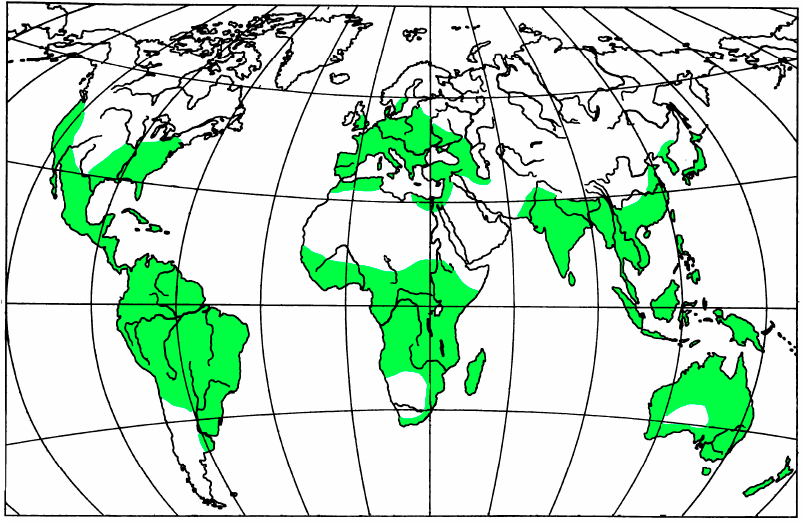
Figure 5. Distribution of Platypodidae.